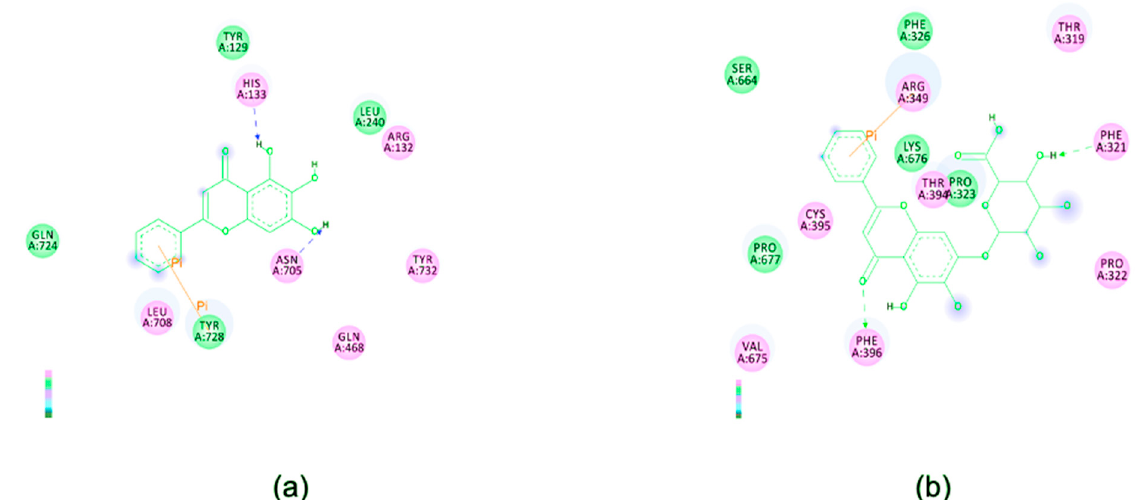
Figure 5. Illustrations of interactions between ( a ) baicalein and ( b ) baicalin and SARS-CoV-2 RdRp. 2D diagrams of ligand–protein interactions showing the amino acid residues involved were generated by Discovery Studio 2.5.